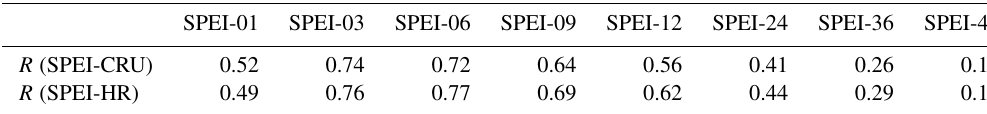
Figure 4. Spatial maps of correlation between SPEI and root zone soil moisture (RSM) for 6-month SPEI: (a) SPEI-HR and (b) SPEI-CRU. The time series of the African area mean RSM and SPEI are shown in (c) , where R refers to the correlation coefficient. The correlations shown here are all significant at the 95% confidence level. Table 2. The correlation ( p < 0 . 05) between area mean RSM and SPEI at different